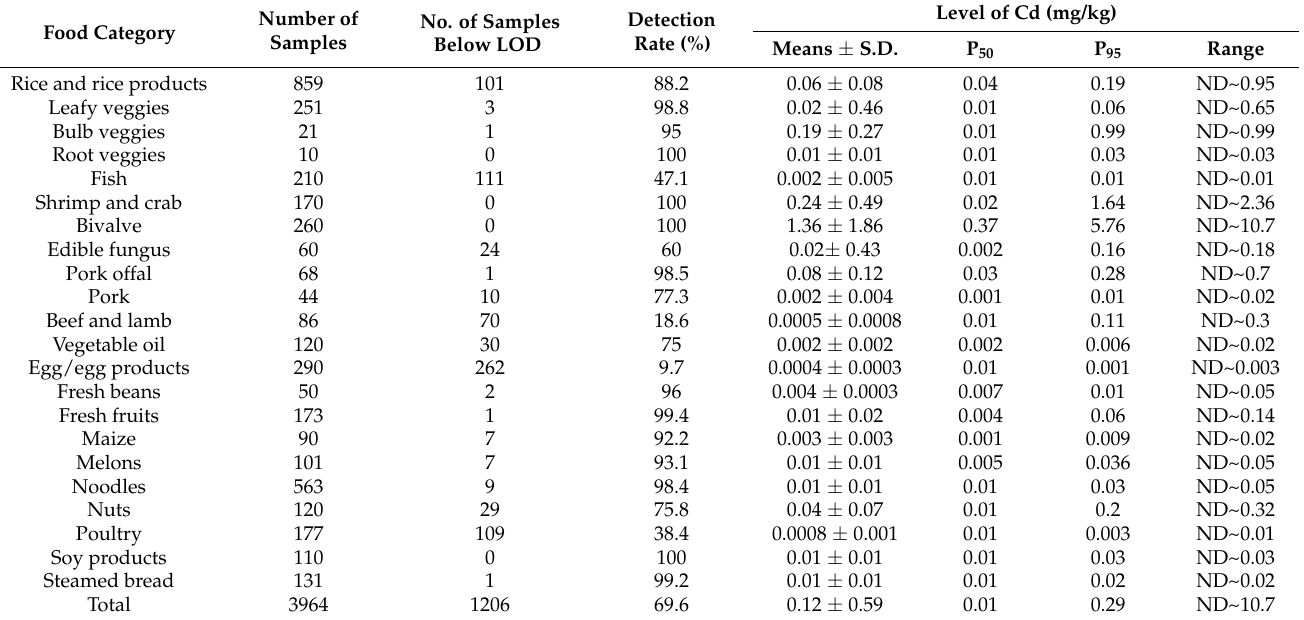
Table 1. Levels of Cd in foods from Guangzhou during 2016–2019.